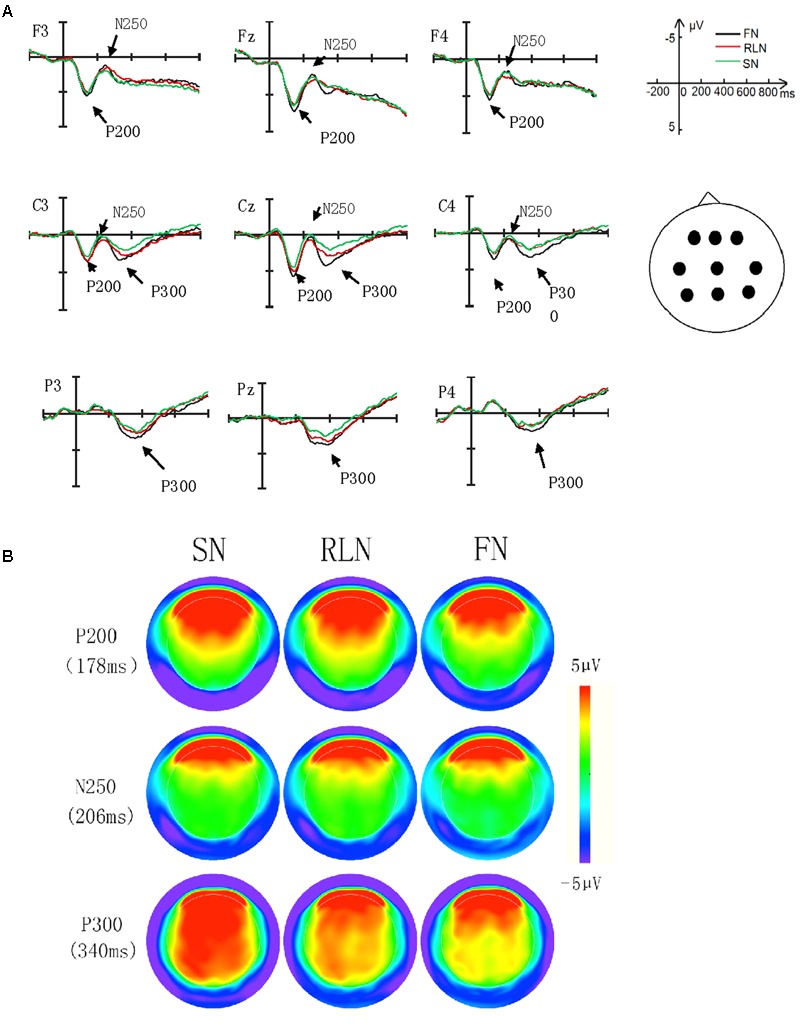
(A) Grand-average ERPs for self-name (SN), religious leader name (RLN), famous name (FN). ERPs are presented for electrode locations chosen for statistical analyses. (B) Topographical distributions of the ERP components-of-interest computed for all experimental conditions averaged together.